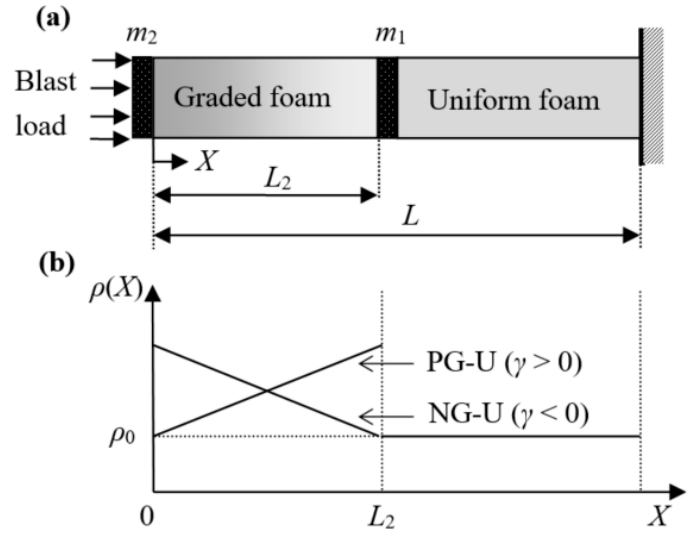
Figure 1. ( a ) Sketch of density graded-uniform cellular cladding for blast alleviation and ( b ) its density distribution.